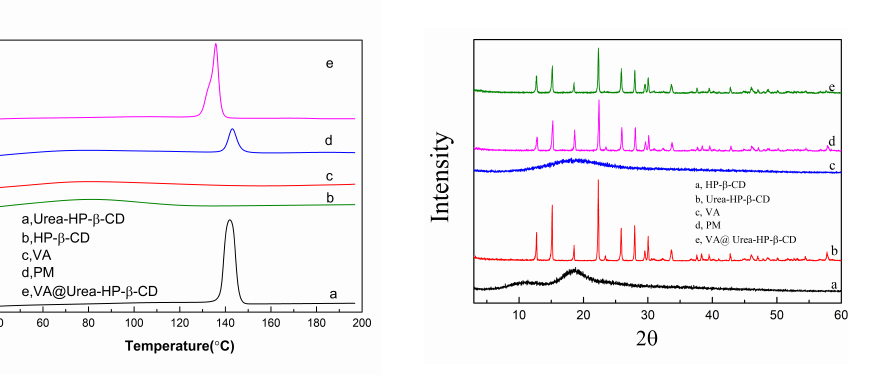
Fig. 1. DSC Thermograms of (a) Urea-HP- β -CD (b) HP- β -CD (c)VA (d) PM (e) VA@ Urea-HP- β -CD.